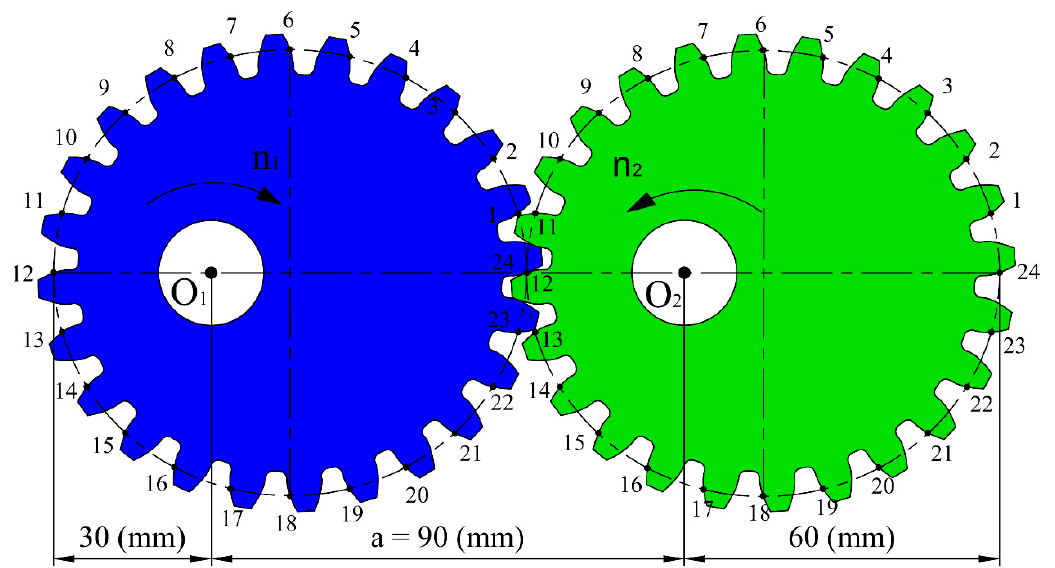
Figure 17. Designed model of elliptical gear set.